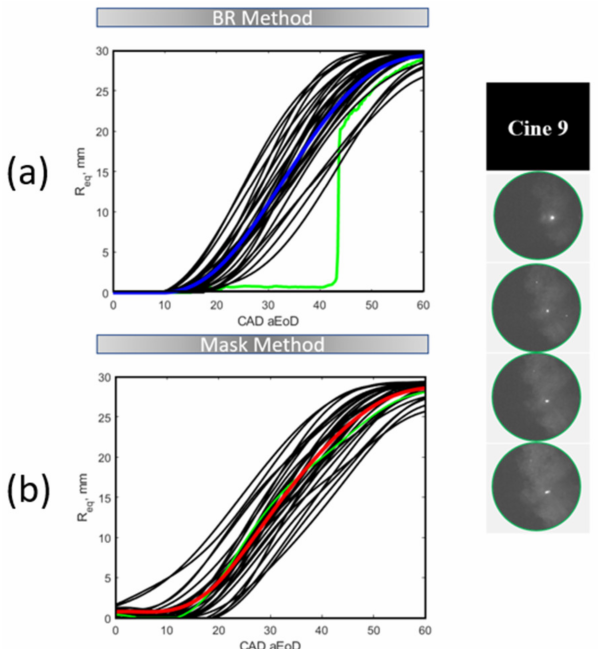
Figure 10. Dispersion of the equivalent flame radius at λ = 1.8 for both analyzed algorithms (( a ) for base reference and ( b ) for Mask R-CNN). The blue curve and red curve indicate the corresponding average value, while the green curve is the case detected as an anomaly from the BR Method. Images on the right represent the flame front evolution of such a case that Mask R-CNN correctly